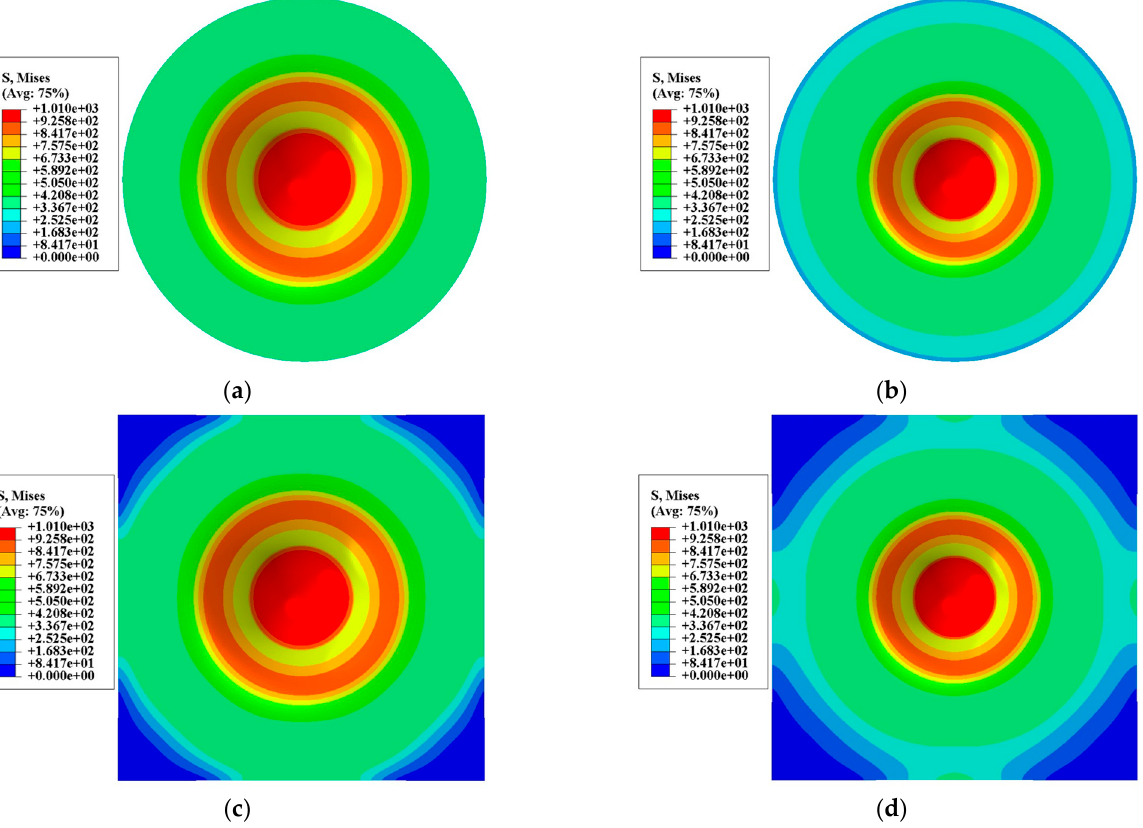
Figure 15. Contour plots for Von Mises stress on FE model of SPT. ( a ) round specimen with a diameter of 8 mm; ( b ) round specimen with a diameter of 10 mm; ( c ) square specimen with a diameter of 8 mm; ( d ) square specimen with a diameter of 10 mm.